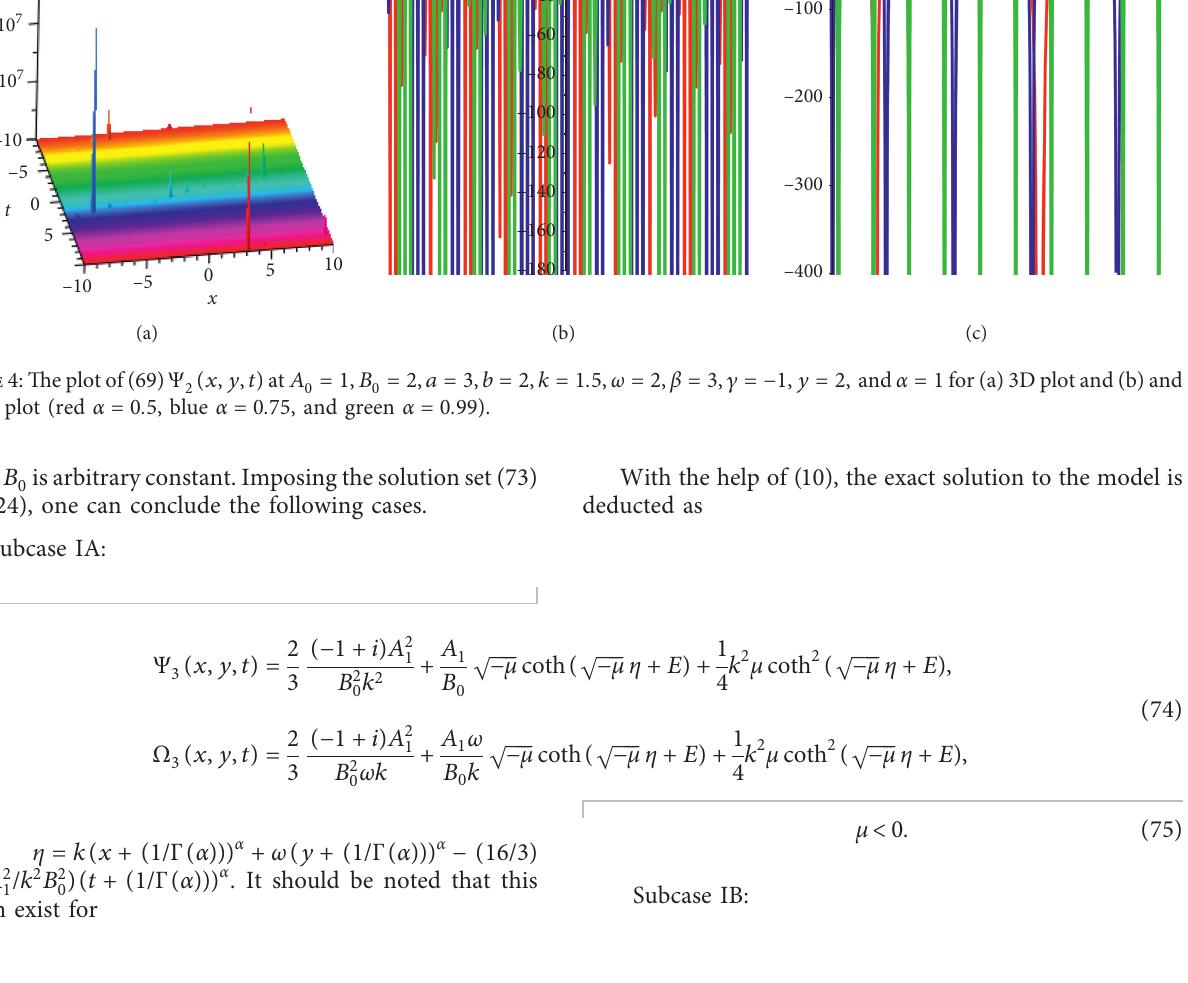
Figure 3: The plot of (69) Ψ plot.